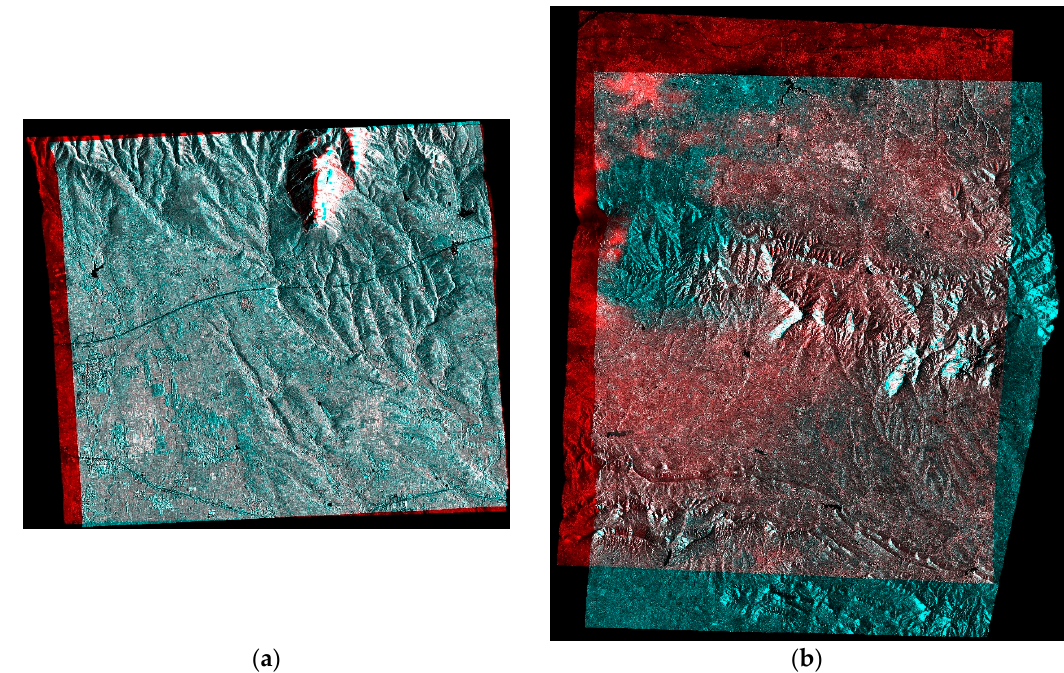
Figure 2. ( a ) Stereo anaglyph of Spotlight epipolar images; ( b ) Stereo anaglyph of Stripmap epipolar images.